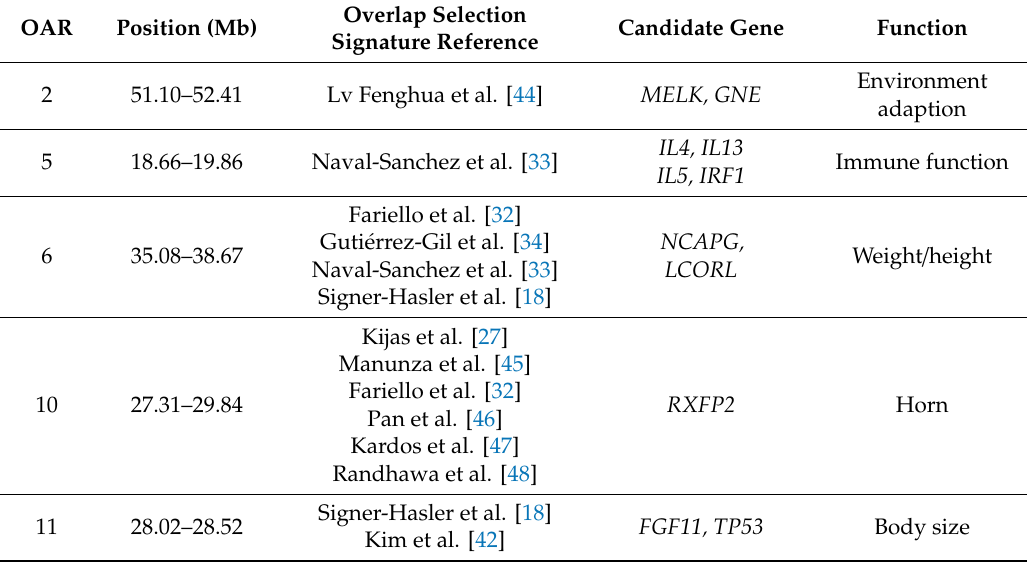
Table 4. ROH hotspots detected in Chinese Merino overlap with the selection signatures in